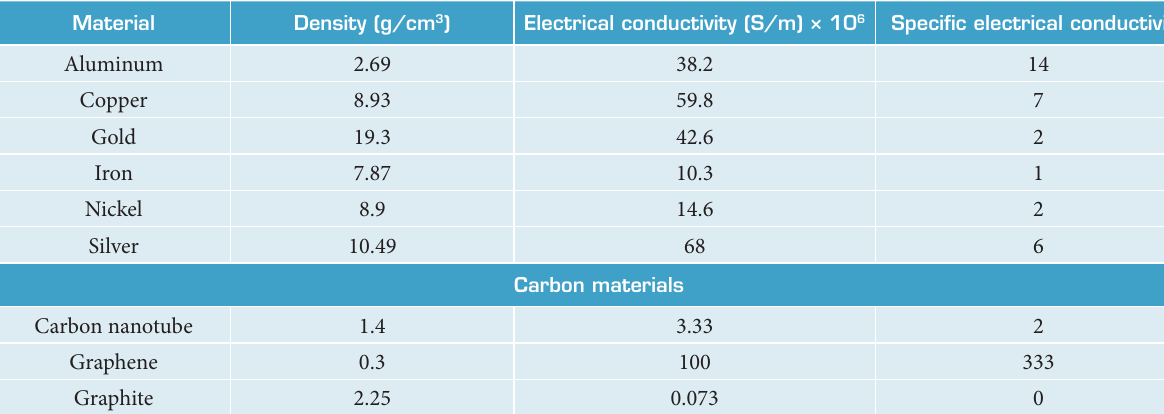
Table 1. Electrical conductivity and density of metal and carbon